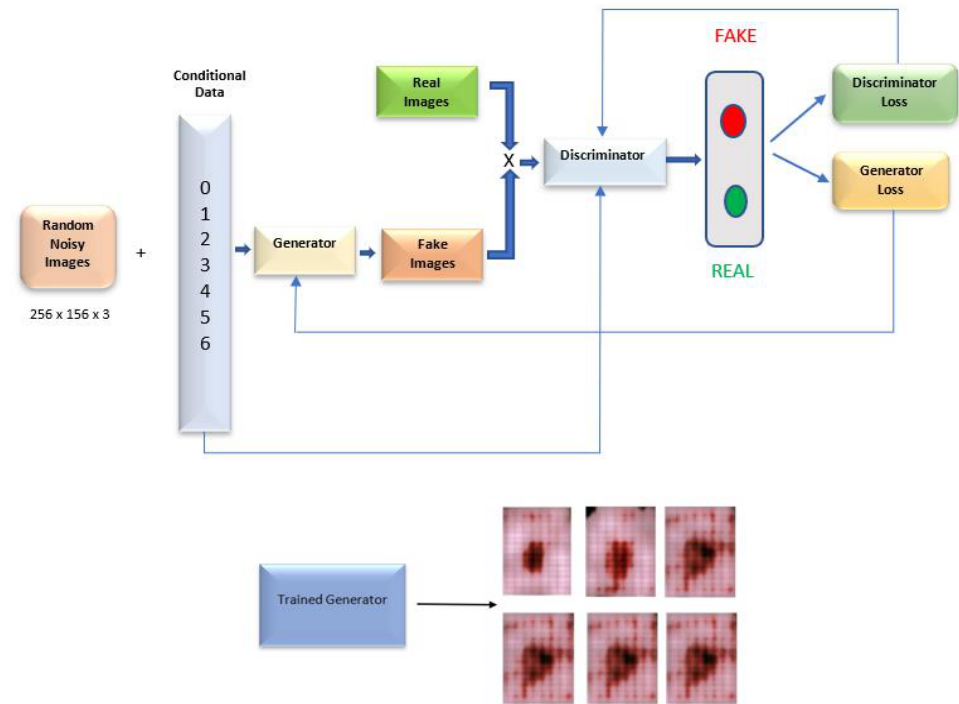
Figure 4. CGAN architecture.